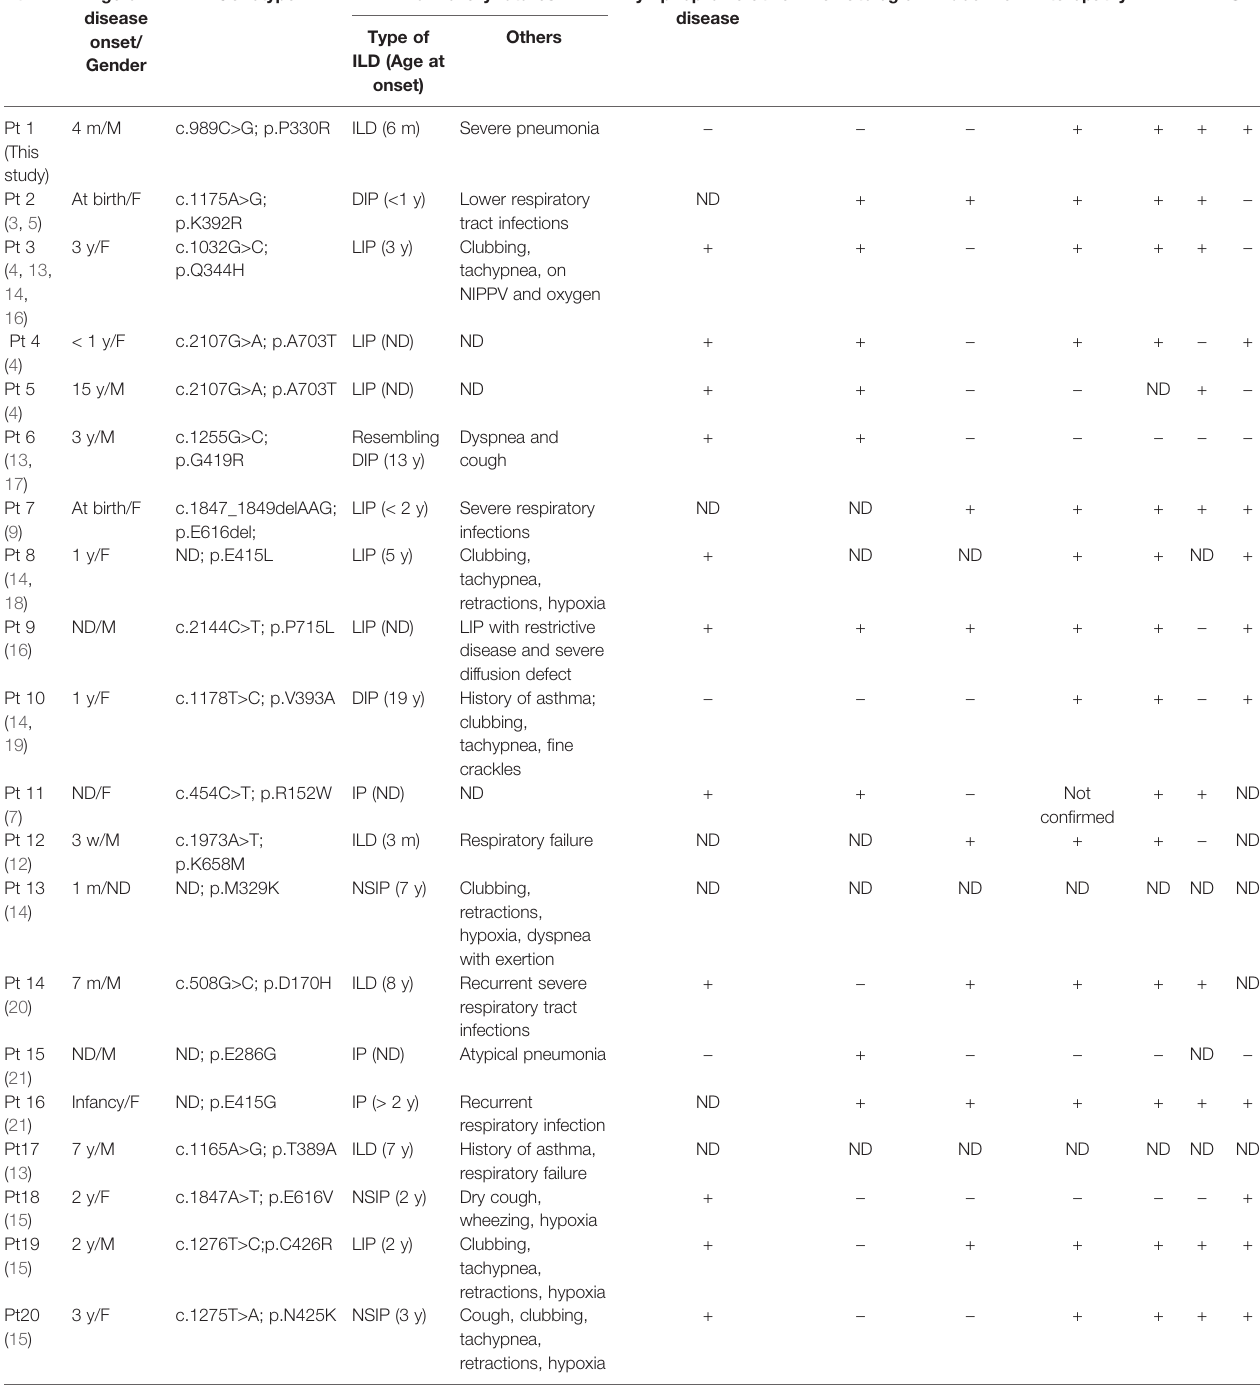
TABLE 2 | Clinical characteristics of STAT3 GOF patients with